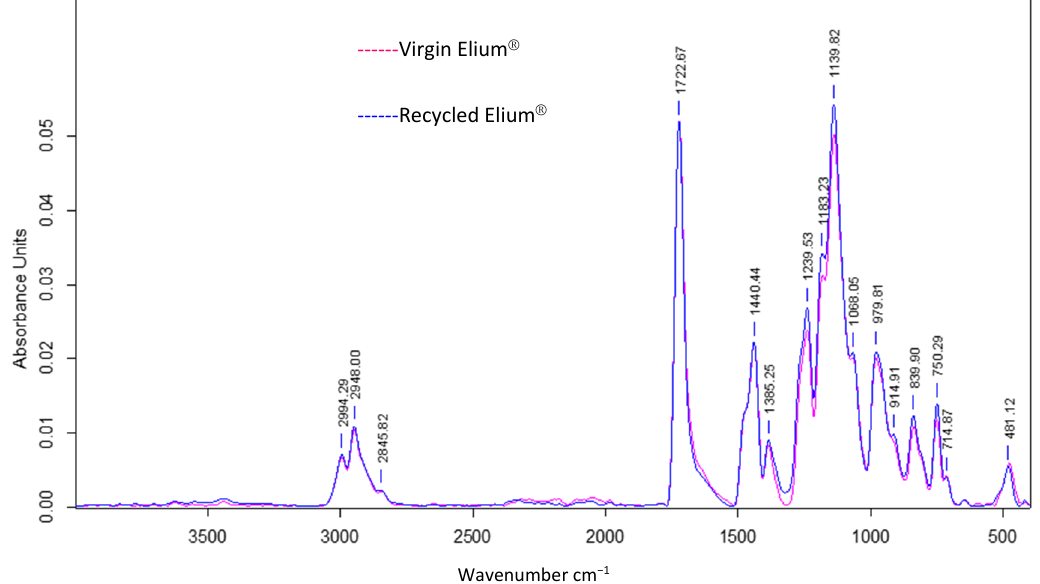
Figure 13. ATR FTIR absorbance spectrum of virgin Elium ® and Elium ® after 24 h of simple dissolution in acetone 1:4.